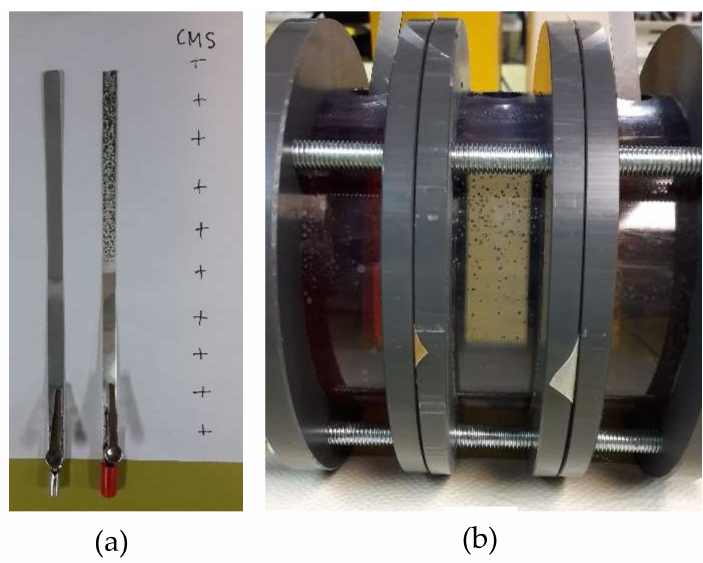
Figure A2. ( a ) Stainless steel anode electrode and silver electrode; ( b ) solutions obtained approximately at the same time as voltage drop starts to